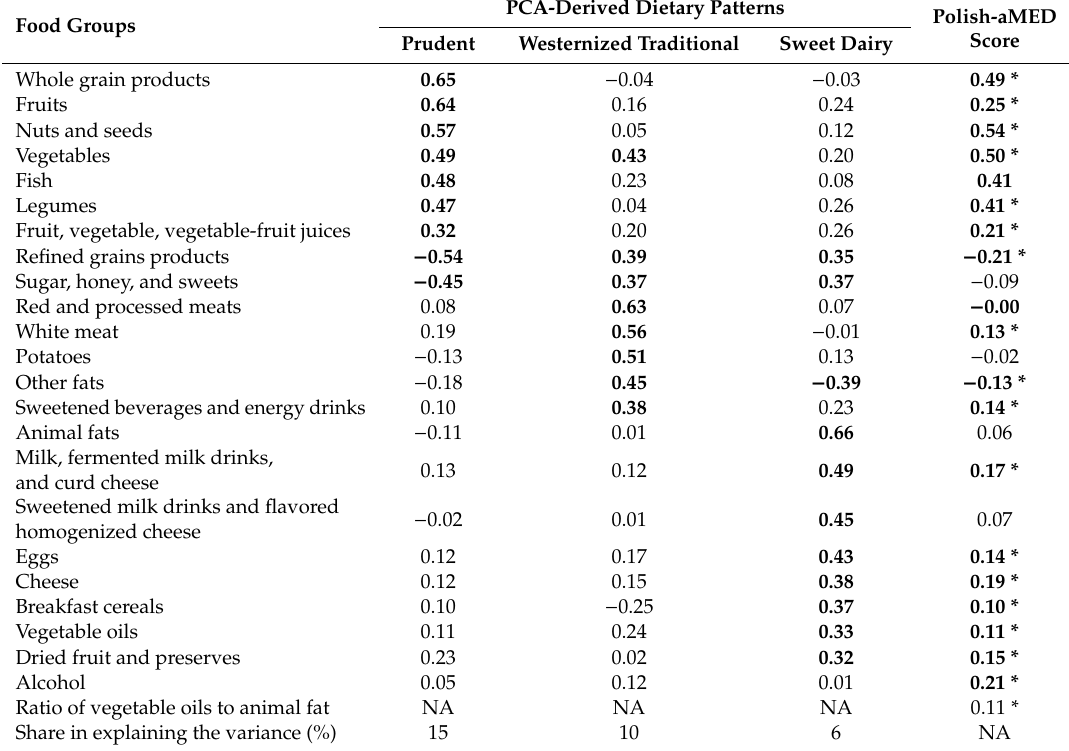
Table 2. Factor loadings for food groups in principal component analysis (PCA)-derived dietary patterns and the Pearson’s correlation coe ffi cients for food groups in the Polish-aMED score ( n = 439). Food